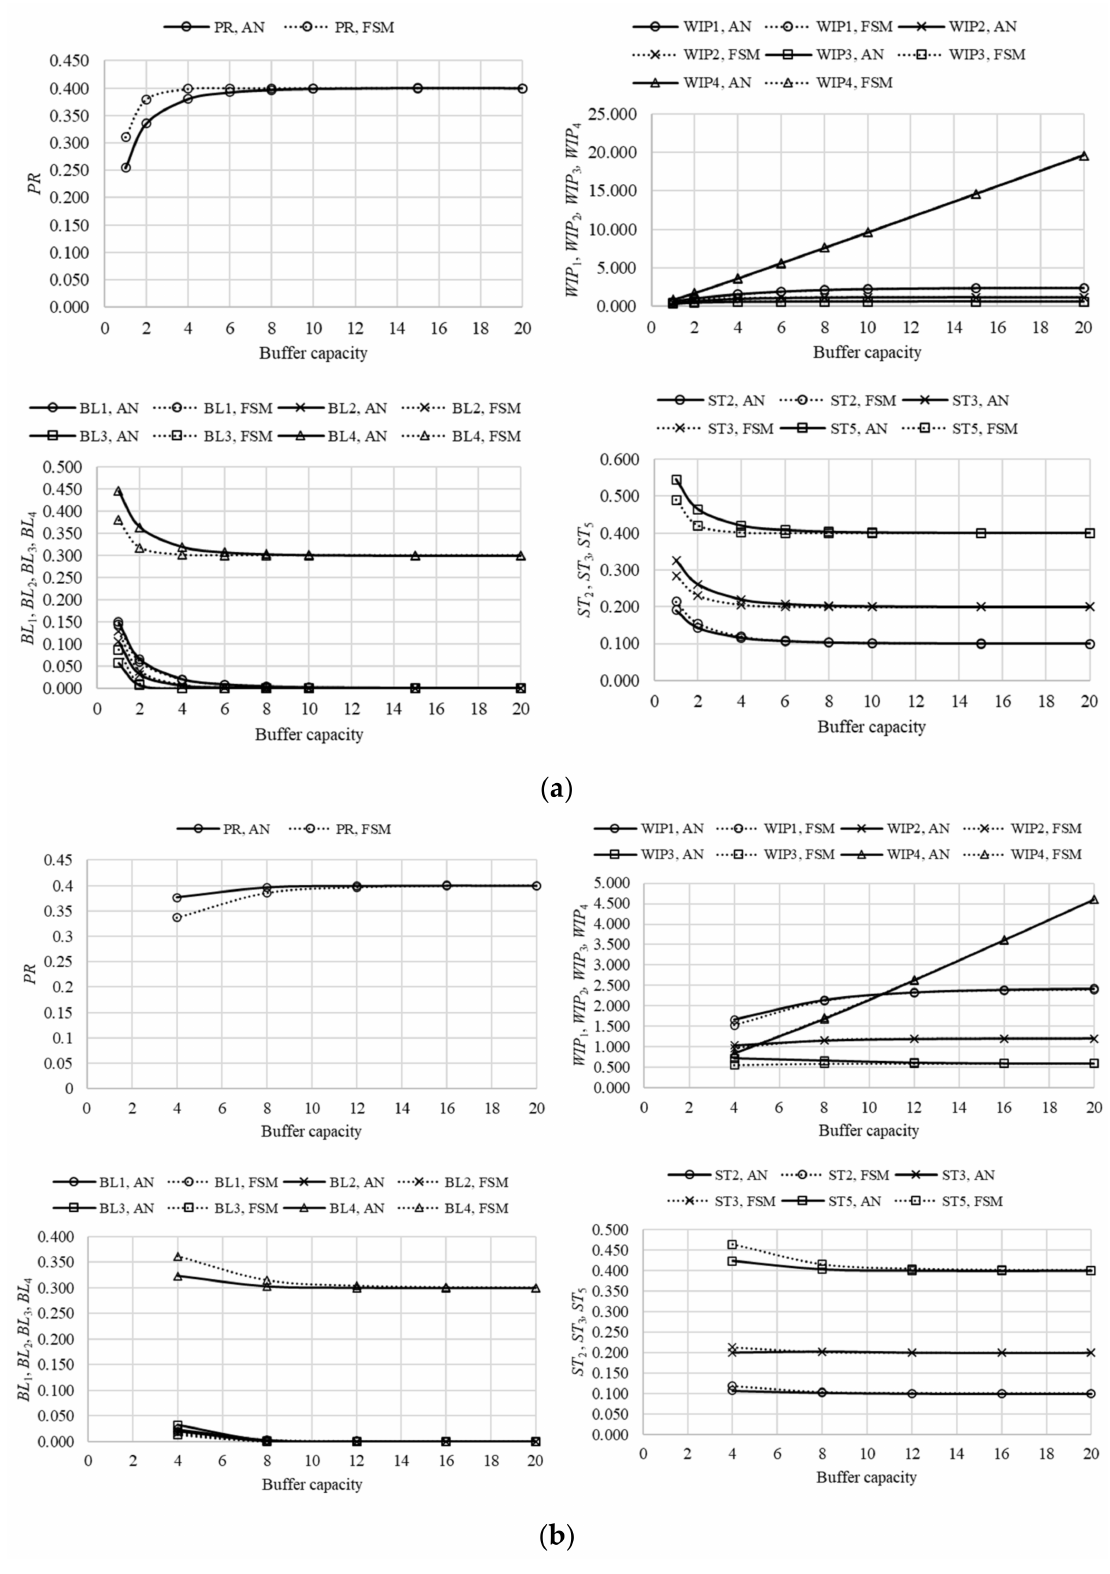
Figure 10. Comparison of the performance measures in the case of line L5B: ( a ) N 1 = N 2 = N 3 = N 4 = N